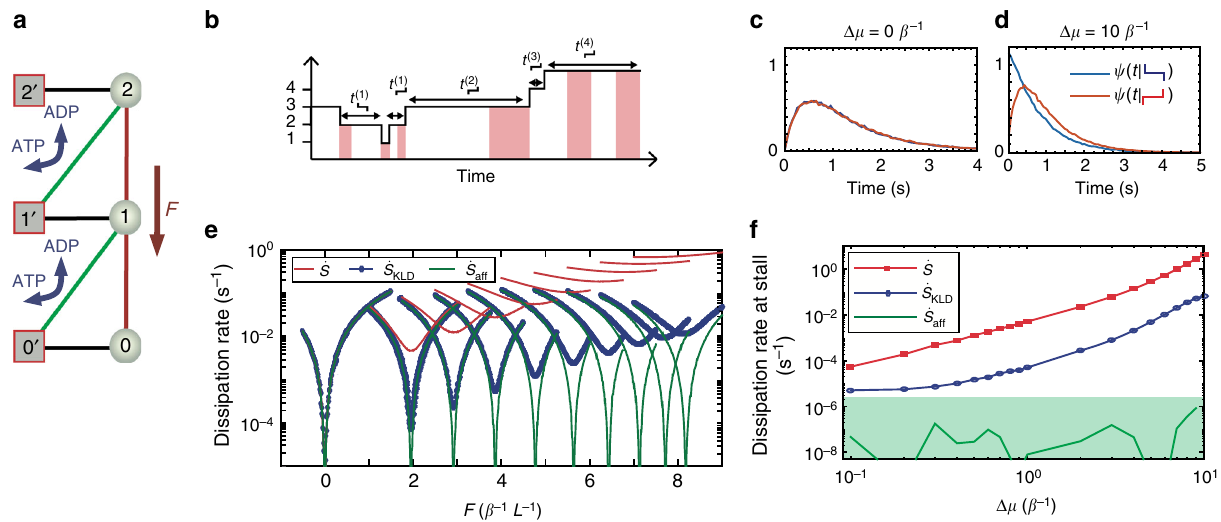
Fig. 4 Molecular motor. a Illustration: Active states (red boxed squares) can use a source of chemical energy while passive states (circles) cannot. The chemical energy is used to power the motor against and external force F . b Illustration of a trajectory for four positions, where the hidden internal active state is denoted by the red shaded regions. c , d Waiting time distributions ψ ( t ) for the up – up (red) and down – down (blue) transitions at stalling for Δ μ = 0 β − 1 ( c ) and Δ μ = 10 β − 1 ( d ). Notice that the distributions are only different in the presence of a chemical drive. e Total entropy production rate _ S (red), af fi nity estimator _ S (green), and entropy production for semi-Markov model _ S for Δ μ = 0 (left) up to Δ μ = 10 (right), as a function of force F , centered aff KLD at the stall force. f Same as ( e ) at stalling as a function of chemical drive. The af fi nity estimator _ S offers a lower bound constrained by the statistical aff uncertainty due to the fi nite amount of data (green shaded region). Calculations were done using the parameters k s = 1 s − 1 , k 0 = 0.01 s − 1 , and the trajectories were sampled using the Gillespie algorithm